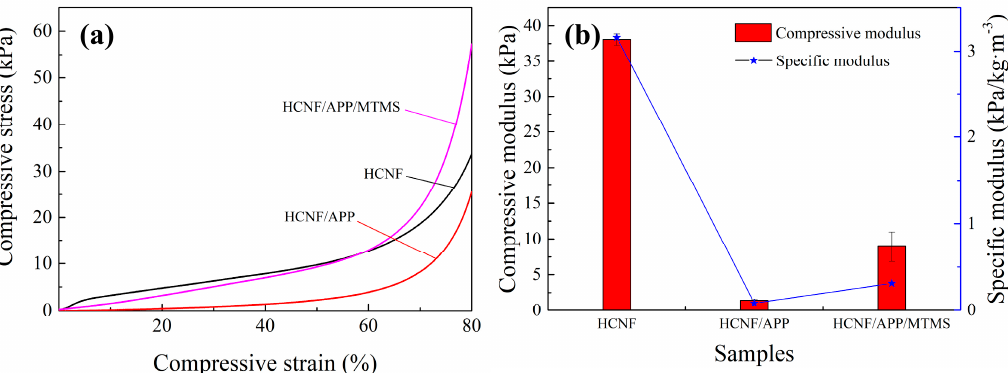
Figure 8. The ( a ) stress-strain curves and ( b ) compressive moduli and specific moduli of the HCNF, HCNF/APP, and HCNF/APP/MTMS aerogels.